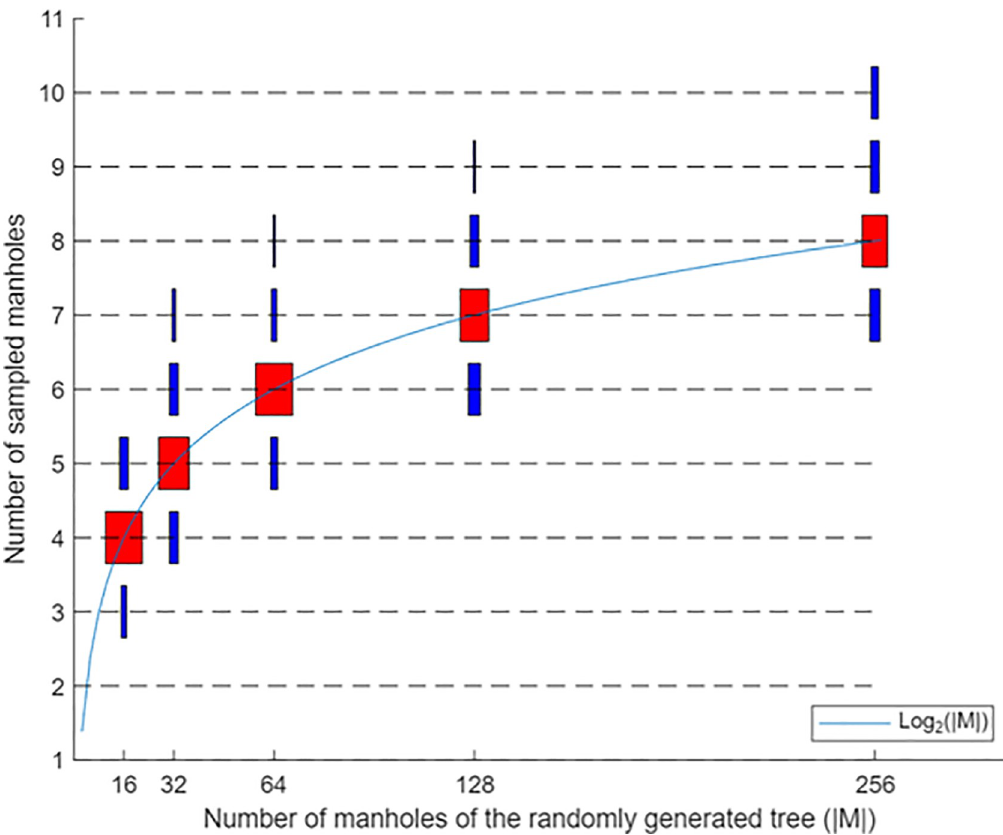
Fig 4. Number of samples required to find the source manhole. Additional model runs with various junction probabilities also showed the same pattern as in the figure.